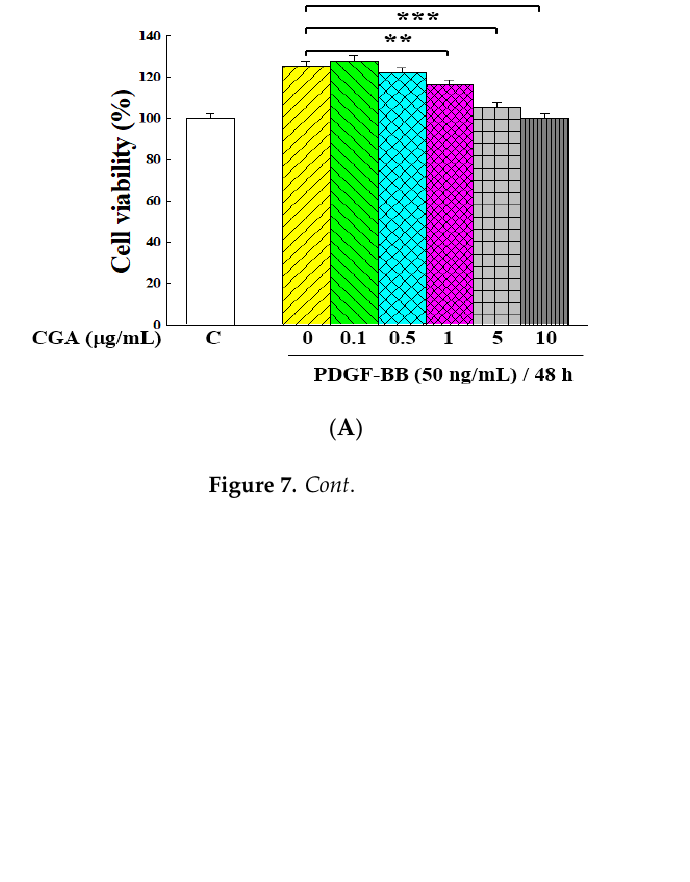
( B ) ( C ) Figure 7. Inhibitory effects of the main GT ingredients on the proliferation of PDGF-BB-stimulated VSMCs: CGA ( A ), lut-7-g ( B ), and lut ( C ). The cell proliferation was conducted under the stimulation of 50 ng/mL of PDGF-BB for 48 h. The cell viability was measured by an MTT assay kit, and the number of cells was regarded as 100% with PDGF-BB stimulation and without sample treatment. Group C was the VSMC growth without PDGF-BB stimulation and sample treatment. Data were